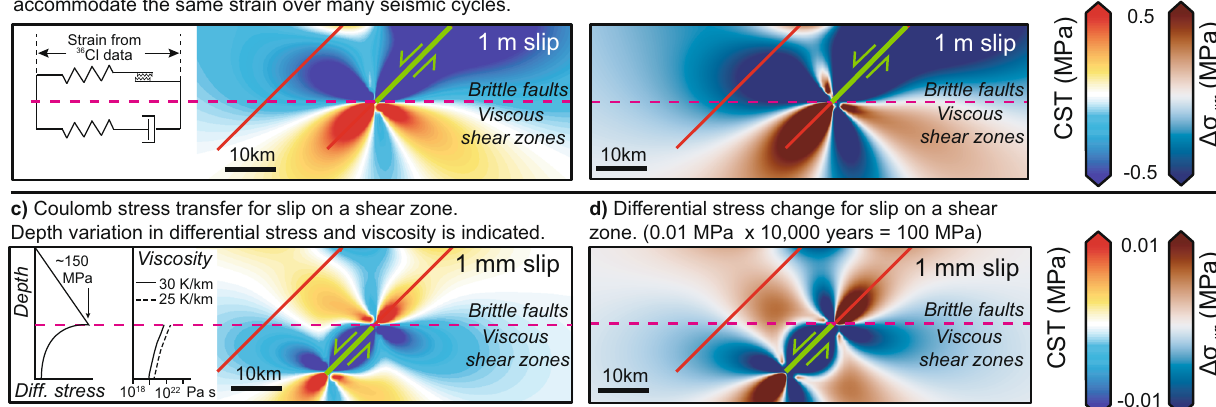
Fig. 2 | Model set-up used to examine stress changes produced by slip in normal faulting earthquakes and by slip on underlying shear zones. a shows Coulomb Stress Transfer (CST) resulting from a normal faulting earthquake. Inset shows the brittle-frictional-viscous components in the upper and middle crust. b shows the differential stress changes resulting from a normal faulting earth- quake. c showsCSTresultingfromsliponaviscousshearzone.Insetsshowtypical values for differential stress 19 and viscosity 24 (for two isotherms) with depth. Note